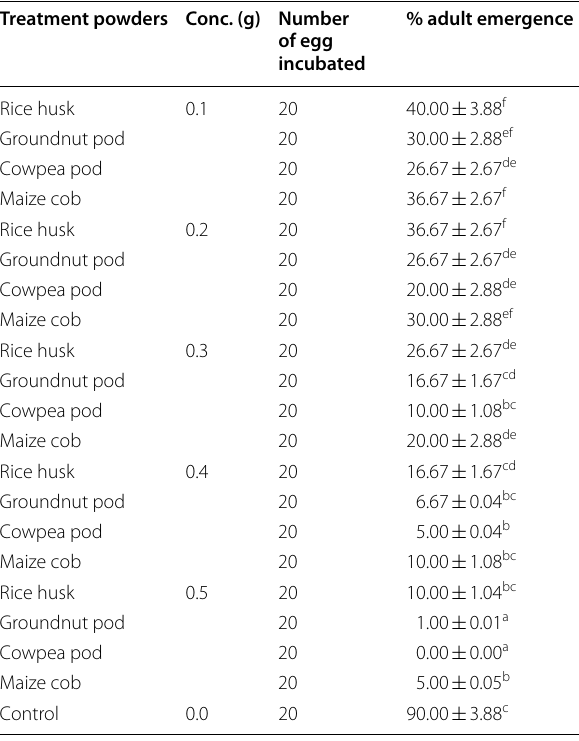
Mean followed by the same letters within the same column are not significantly different ( p > 0.05)